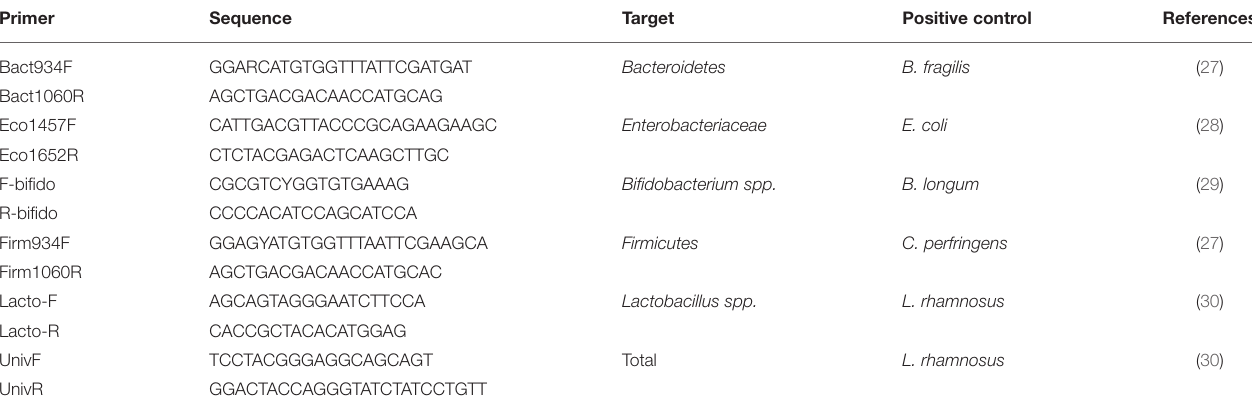
TABLE 1 | The primers and positive control used in this